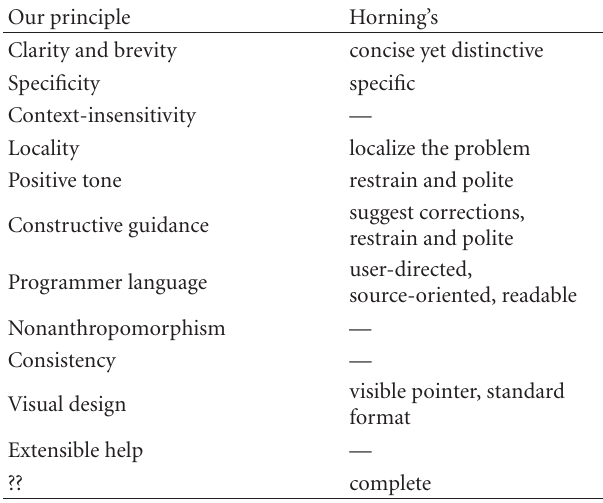
Table 1: Characteristics that error messages should have (Horning’s [39] and proposed